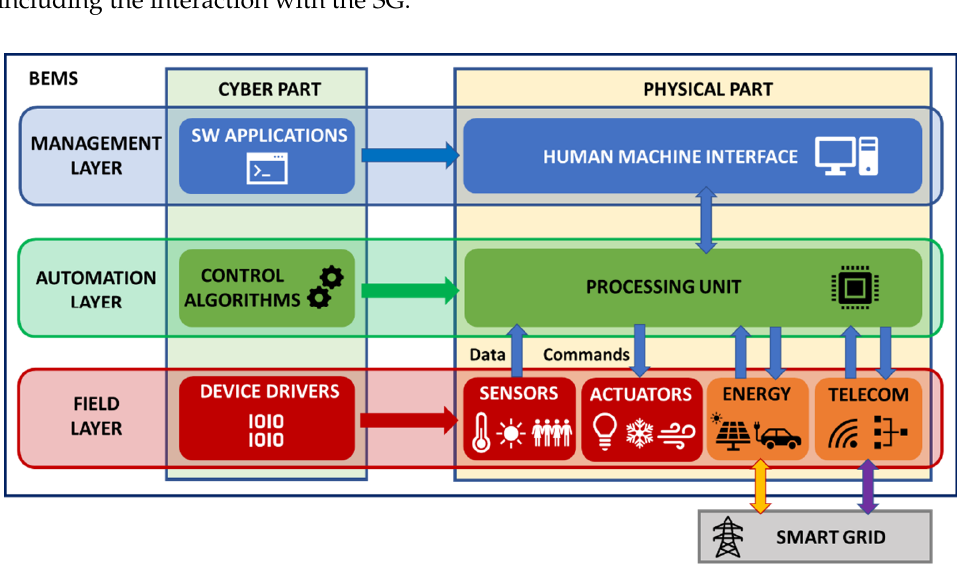
Figure 4. BEMS conceptual architecture.